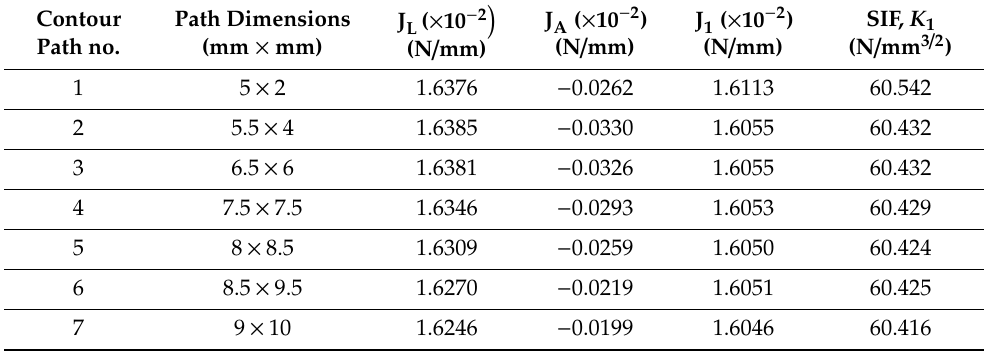
Table 1. Computational SIF values obtained for seven integration paths on the internal crack. Contour Path no.